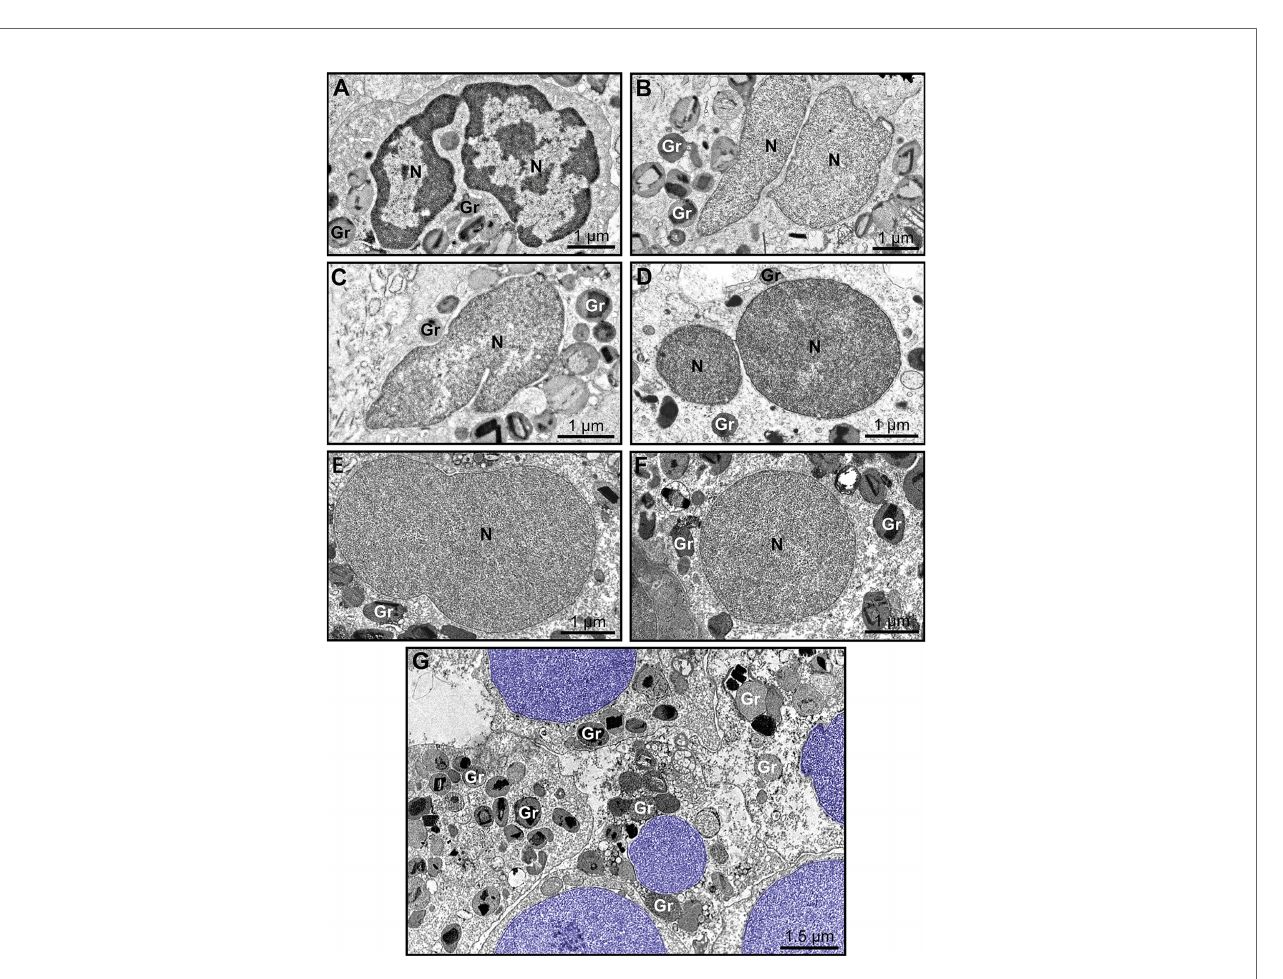
FIGURE 4 | Early ultrastructural signs of ETosis in tissue in fl ammatory eosinophils. (A) A representative intact eosinophil displaying typical bilobed nucleus (N) with clear distinction between euchromatin (electron-lucent) and heterochromatin (electron-dense). (B – F) Decondensed nuclei (N), with homogenously distributed euchromatin, and in different stages of delobulation and rounding denote, early ETosis. While in (B, C) nuclear segmentation is still partially observed, (D – F) show nuclei in advanced process of delobulation and rounding. In (G) , a tissue area with several decondensed, completely round nuclei (colored in purple). Biopsy intestinal samples from patients with ulcerative colitis (n= 16) prepared for TEM. Gr, secretory